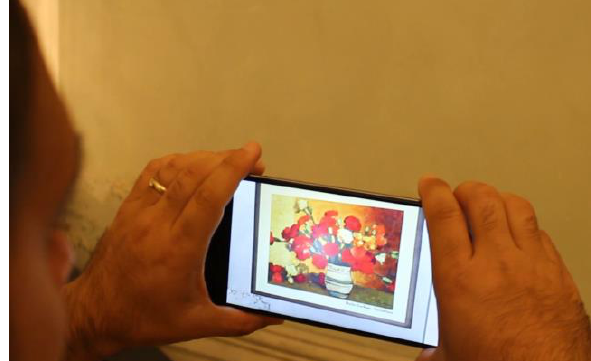
Figure 2. User looking at the painting “Still Nature – Carnations” by Romanian painter Stefan Luchian